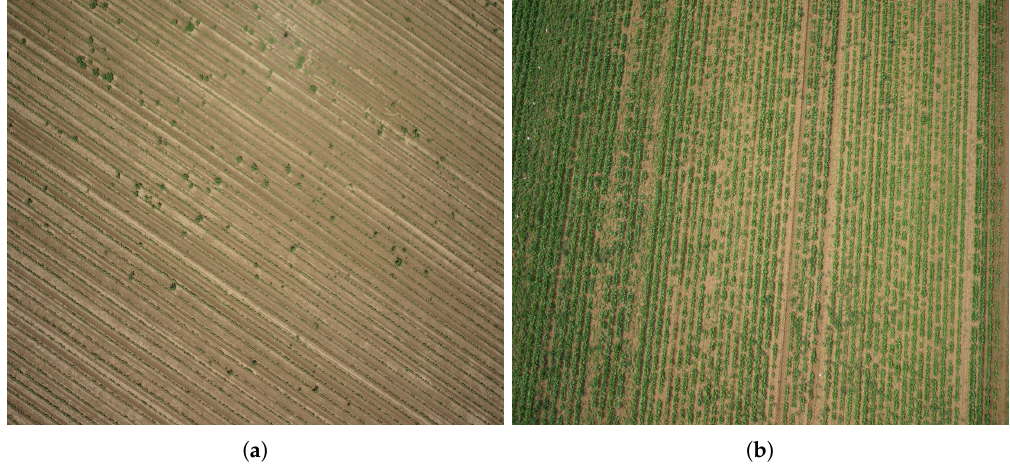
Figure 6. Example of images taken in bean ( a ) and spinach fields ( b ). The bean field has fewer inter-row weeds and is predominantly composed of potential weeds. The inter-row distance is stable and plants are sparse compared to the spinach field, which presents a dense vegetation in the crop rows and irregular inter-row distances. The spinach field has more inter-row weeds and has few potential